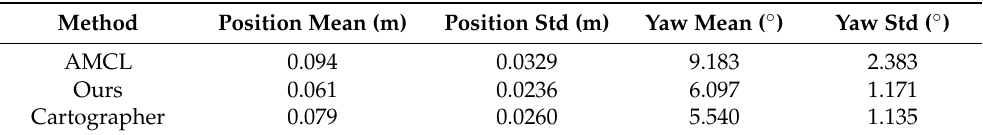
Figure 20. Actual positioning error of mobile robot. The left figure shows the position error of the mobile robot platform and the right figure shows the angle error of the mobile robot platform. Table 2. Three algorithms positioning error